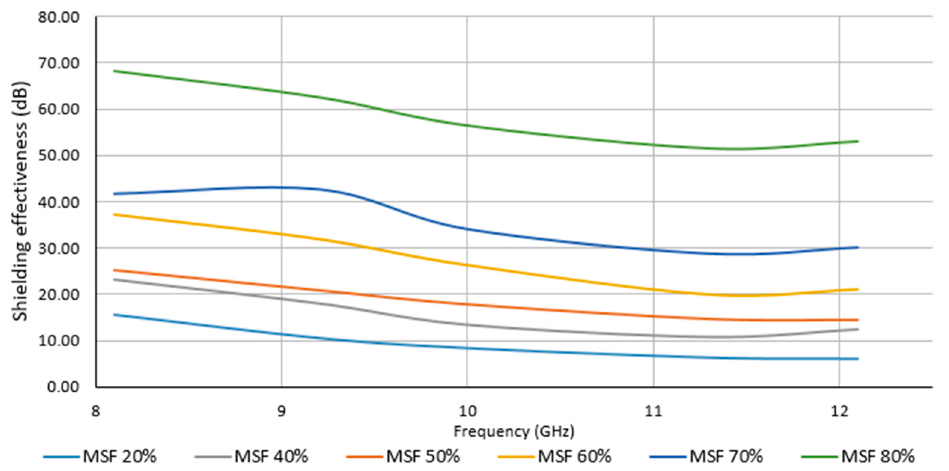
Figure 28. SE dependence on the weight fraction of the filler (iron flake scale).